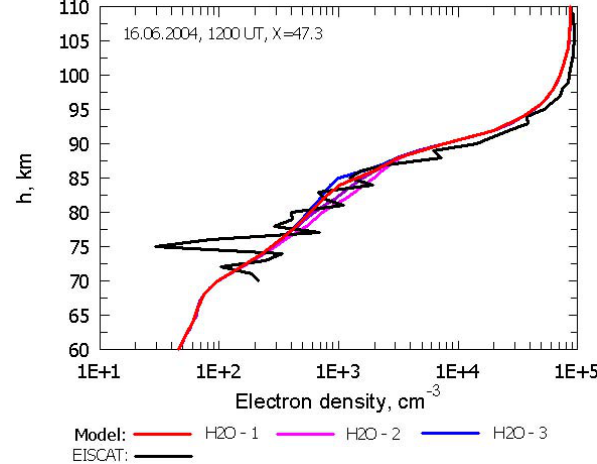
Fig. 4a. Seasonal variation in the B (NO + ) efficiency calculated based on the H 2 O-1 and H 2 O-2 profiles for 75 and 80km.